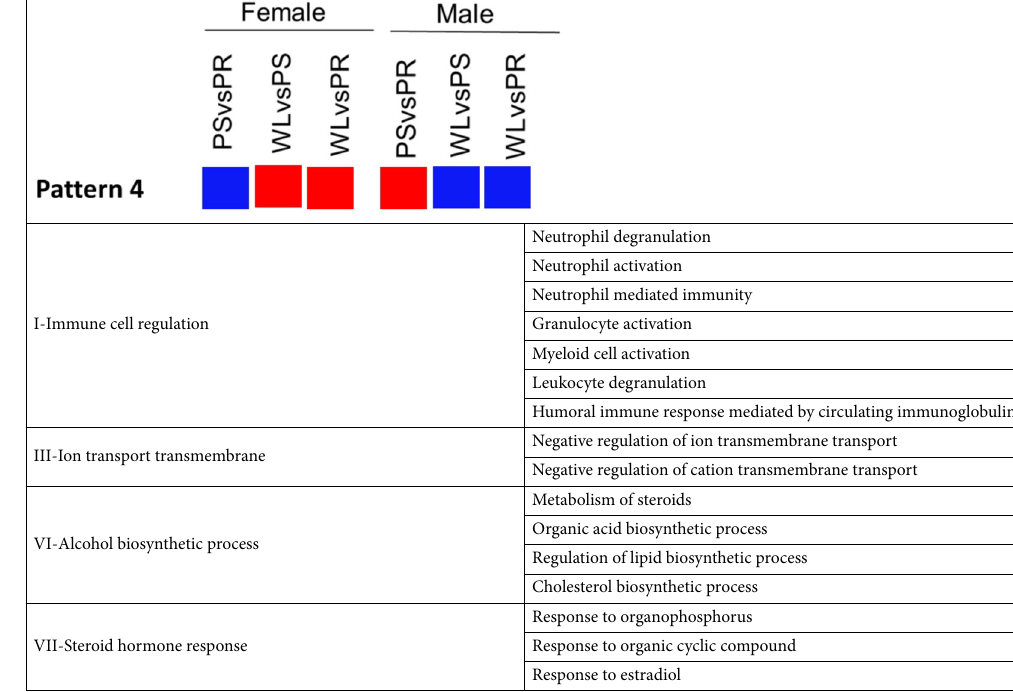
Table 4. Summary of clusters and gene sets included in the pattern 4 for the renal IRI time comparison.